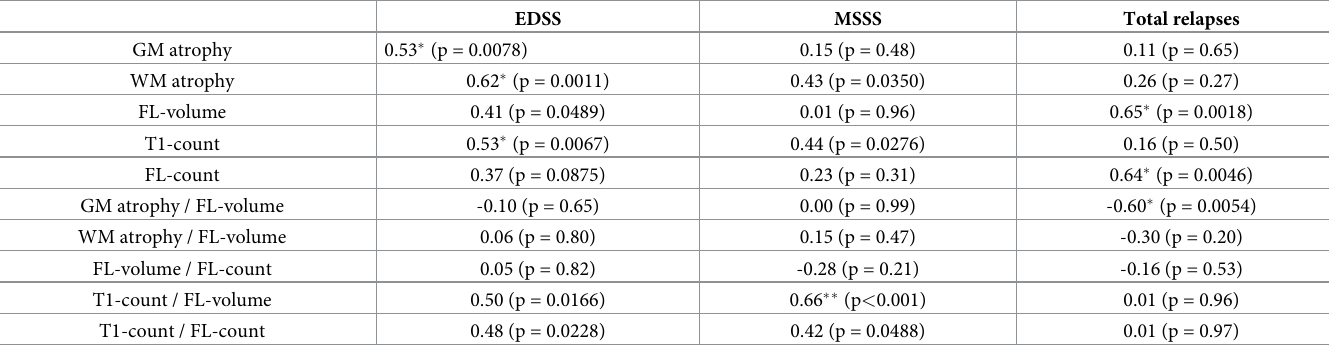
Table 3. Correlation matrix among the patients without spinal cord lesions (n =